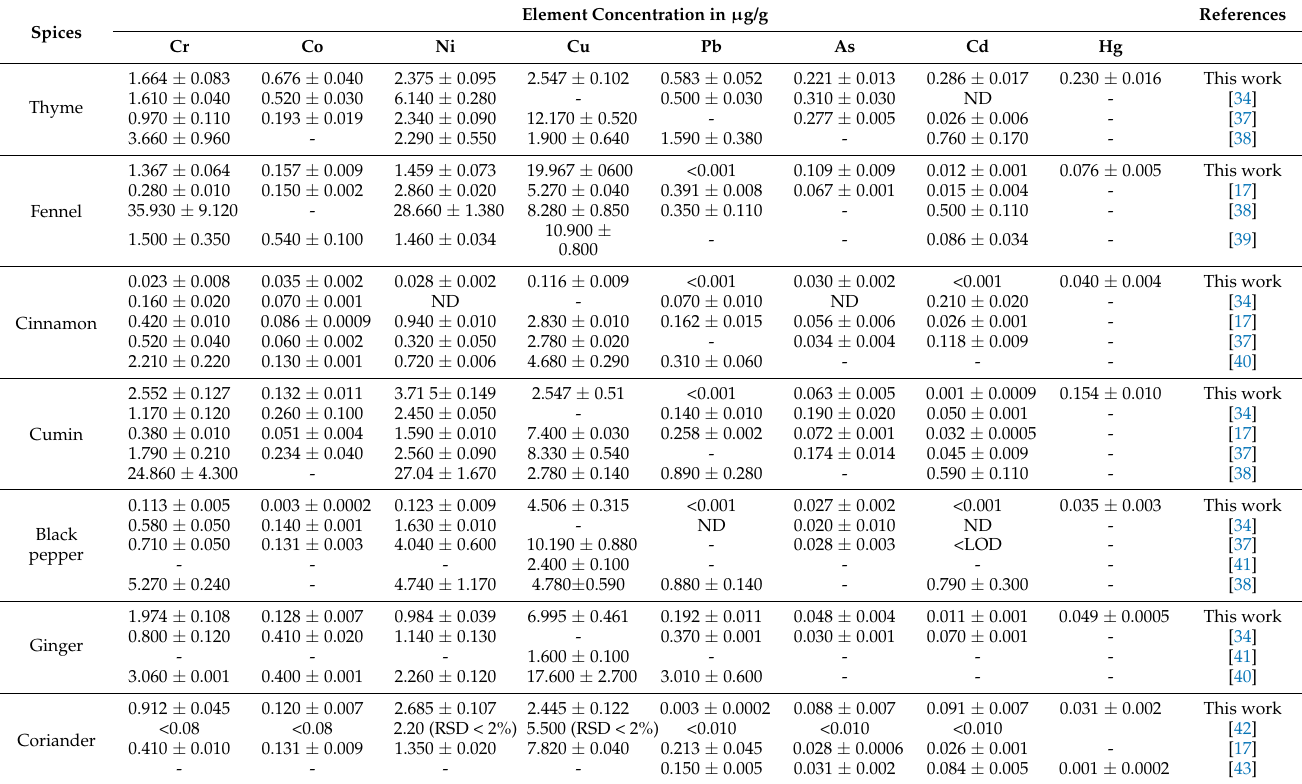
Table 2. Comparative reported values for the investigated elements in some widely used spices: this study versus other